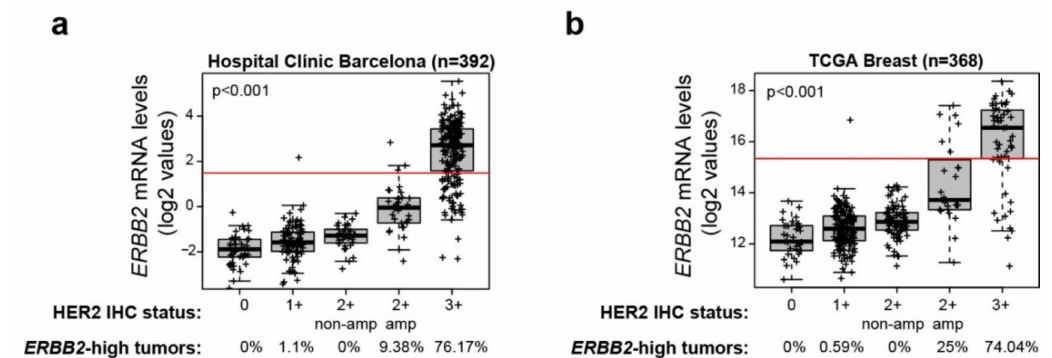
Figure 4. ERBB2 mRNA expression in BC across the HER2 IHC groups. Distribution of ERBB2 mRNA levels across HER2 IHC subgroups of the primary BC ( a ) HCB and ( b ) TCGA datasets. The proportion of ERBB2 -high tumors is indicated as defined by the ERBB2 mRNA cuto ff (shown as a red line). p -values were determined using one-way analysis of variance.